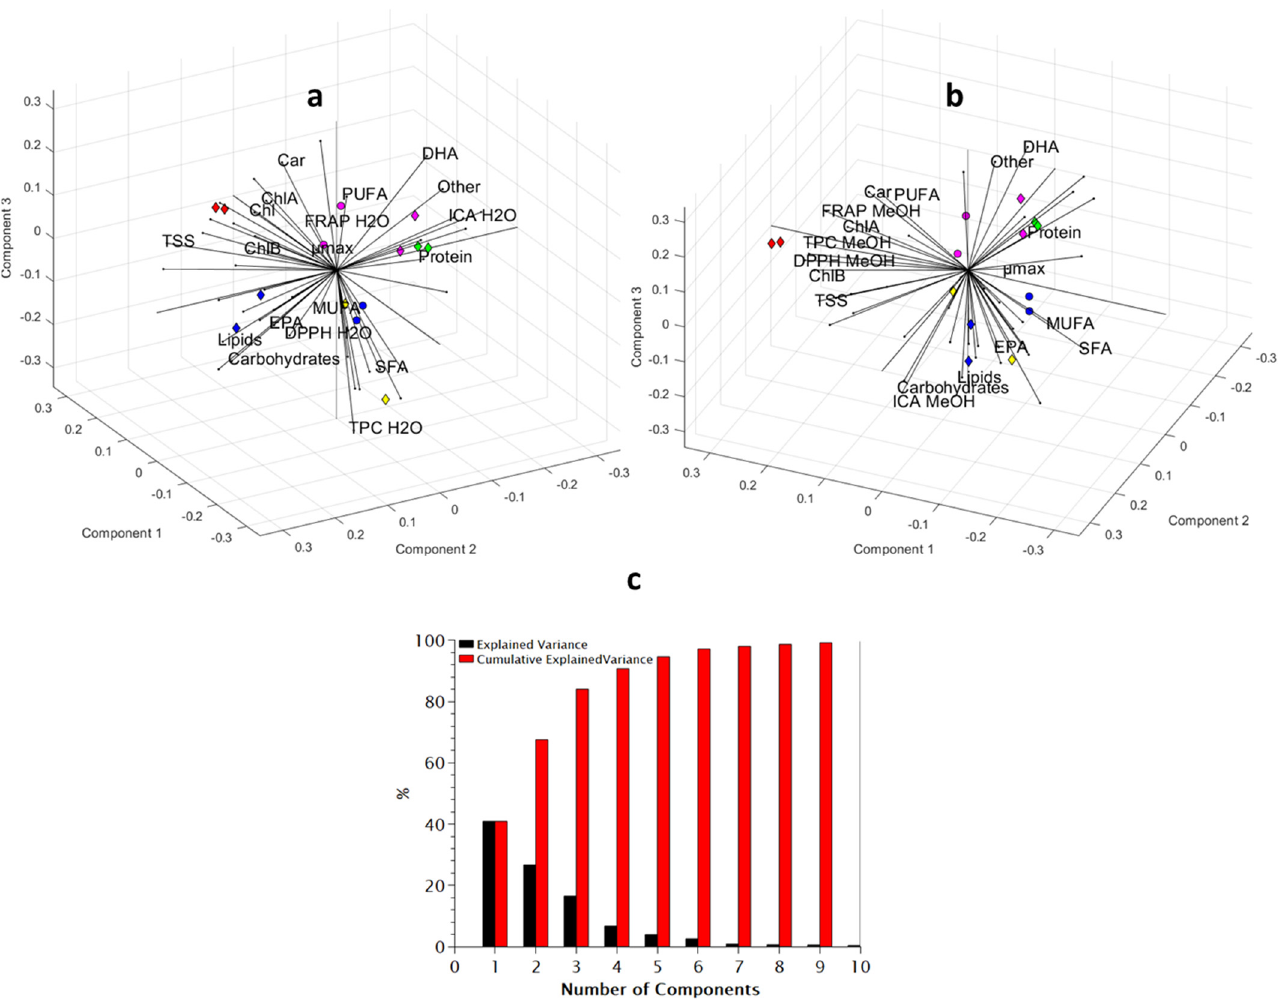
Figure 5. ( a , b ) * ** Biplots of the first three PCA components on proximate composition (84.07% of the explained variance). EPA and DHA here represent the percentage in the dry biomass, while SFA, MUFA, and PUFA are percentages in the total lipids. Markers represent data (color indicates species and marker type indicates growth phase) and are grouped by similarity. The variation of data is expressed by the position of datapoints in a three-dimensional plot of three components that are composed of all the characteristics under analysis. Lines that originate from the origin of the graph represent the characteristics used to synthesize the principal components. The length of each line is proportional to the contribution of the corresponding characteristic to the principal components.